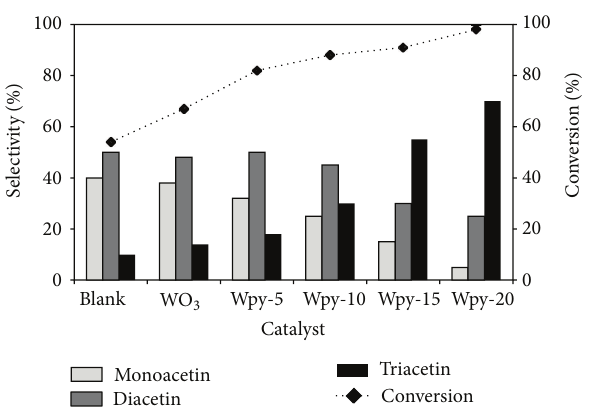
Figure 13: Influence of catalyst weight on conversion and selectivity. (Reaction temperature: 110 ∘ C; reaction time: 10h; AcOH/Gly molar ratio: 6.)